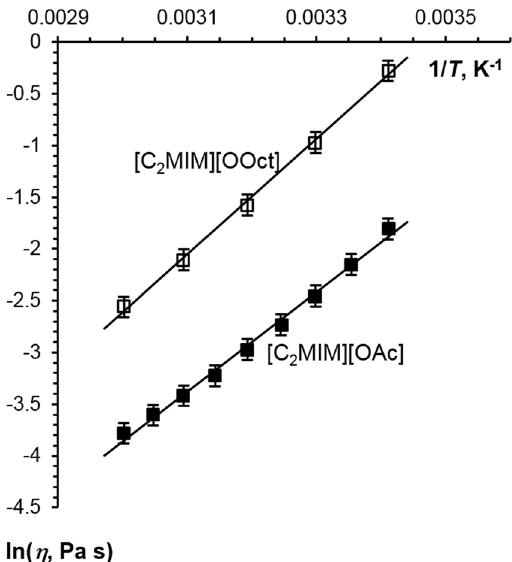
Figure 3. Newtonian viscosity as a function of inverse temperature for [C 2 MIM][OOct] and [C 2 MIM][OAc]. Lines are linear fits.